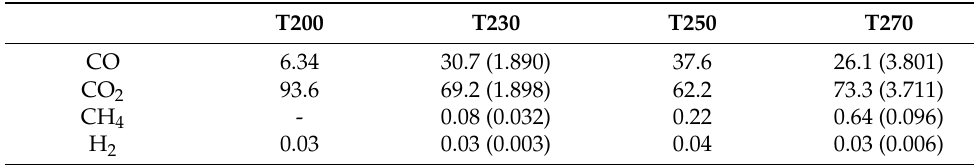
Table 5. The composition of condensable compounds in torr-gas (wt.%). Numbers in parentheses indicate the standard deviations for triple